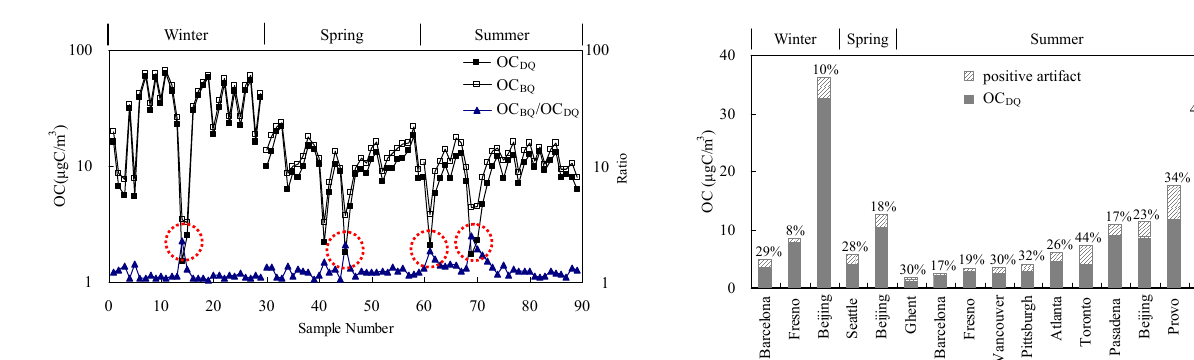
Fig. 6. Comparison of OC concentration determined by denuded Figure 6. Comparison of OC concentration determined by denuded (OC DQ ) and undenuded (OC DQ ) and undenuded (OC BQ ) quartz filter. The ratio of OC BQ to (OC BQ ) quartz filter. The ratio of OC BQ to OC DQ (OC BQ /OC DQ ) is also shown. The peak of OC BQ OC DQ (OC BQ /OC DQ ) is also shown. The peak of OC BQ to OC DQ to OC DQ ratio is marked by the red-dotted cycle. ratio is marked by the red-dotted cycle.